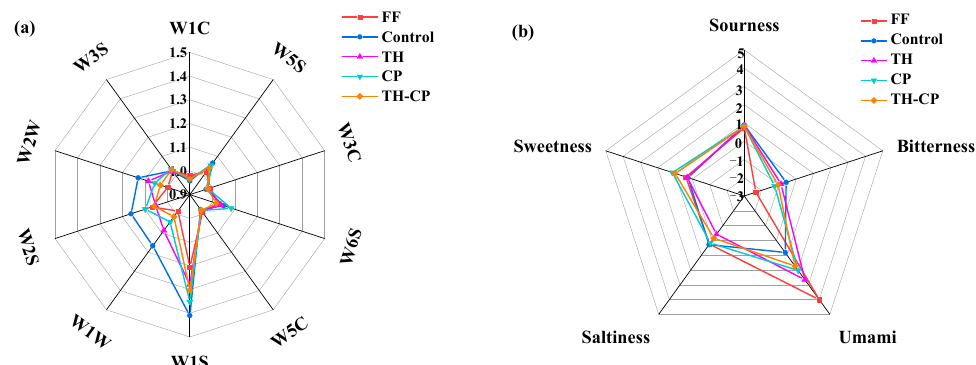
Figure 3. Analysis of ( a ) electronic nose and ( b ) electronic tongue of fillets induced by freeze-thaw cycles with different treatments. cycles with different treatments.